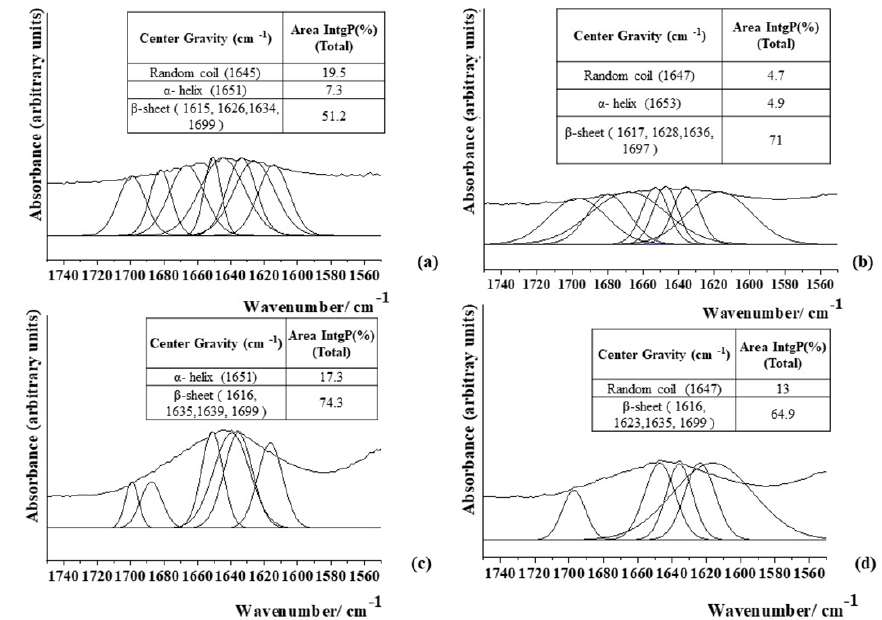
Figure 1. FTIR spectra of secondary structure of the 2% SF solution alone ( a ) and after producing Ty–GG/SF hydrogels via HRP and H2O2, C1 ( b ), C2 ( c ) and C3 ( d ). The spectrum of 2% ( w / v ) SF protein (Figure 1a) revealed an absorption band at 1651 cm − 1 (7.3%),